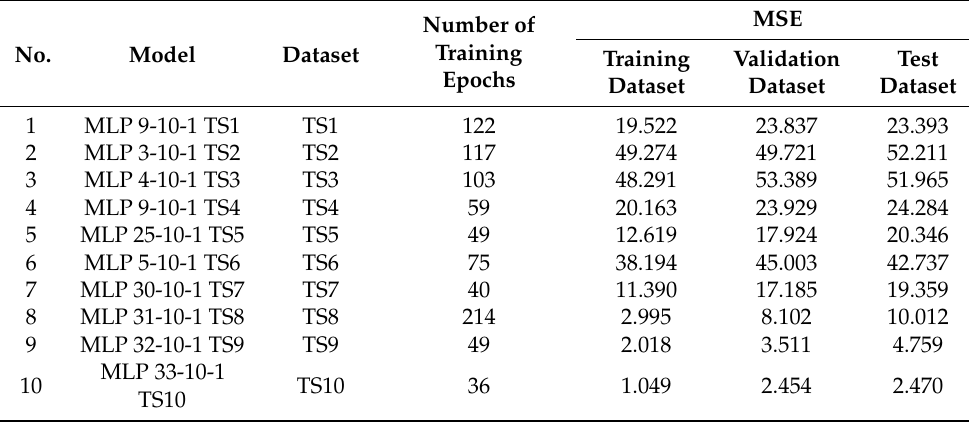
Table 4. Neural models for the prediction of the total solids content in composted